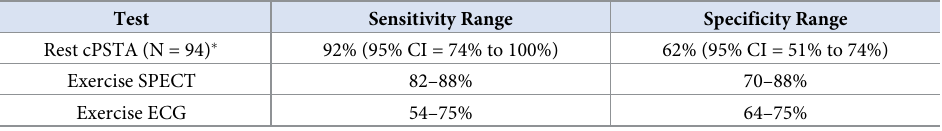
Table 2. Detecting flow-limiting CAD. Machine-Learned Predictor (cPSTA) Compared to Exercise SPECT [7] and Exercise ECG [7,